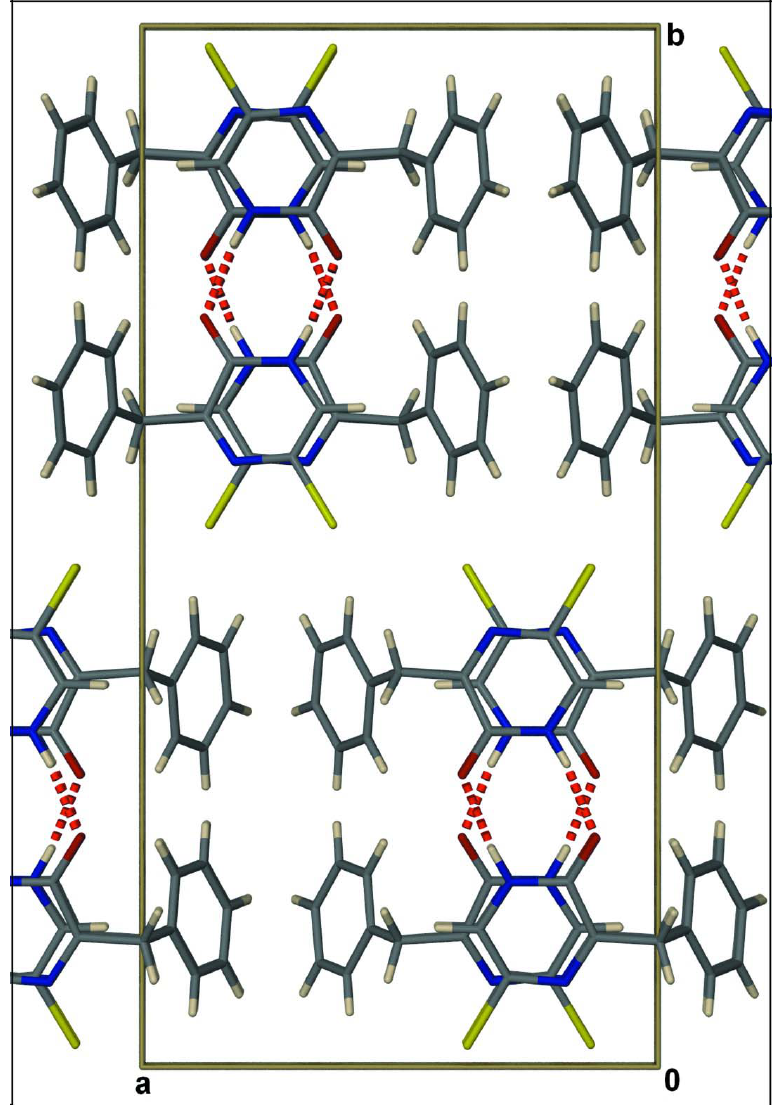
The packing of (I) viewed down [001]. 3-Benzyl-5-bromopyrazin-2(1 H